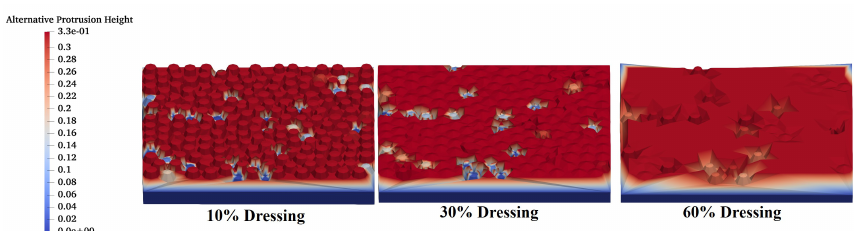
Figure 42. Dressing effects on surface topography for 10%, 30%, and 60% percentual dressing of grit